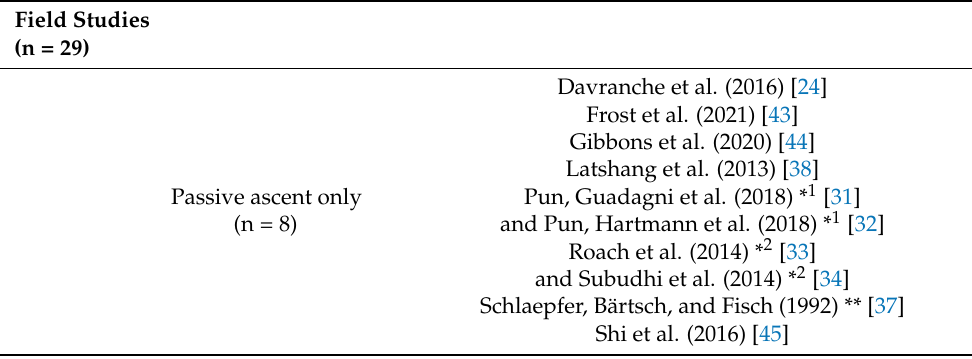
Table 1. Study classification according to type of